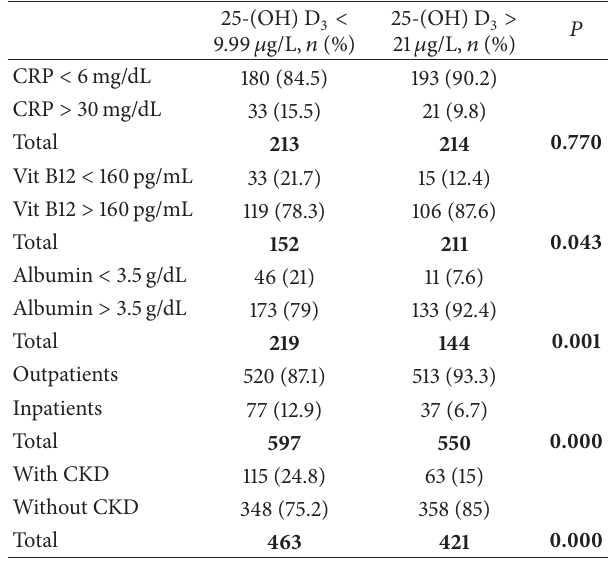
Table 6: The frequency of CRP, vitamin B12, hospitalization, and renal failure in 25-(OH) vitamin D